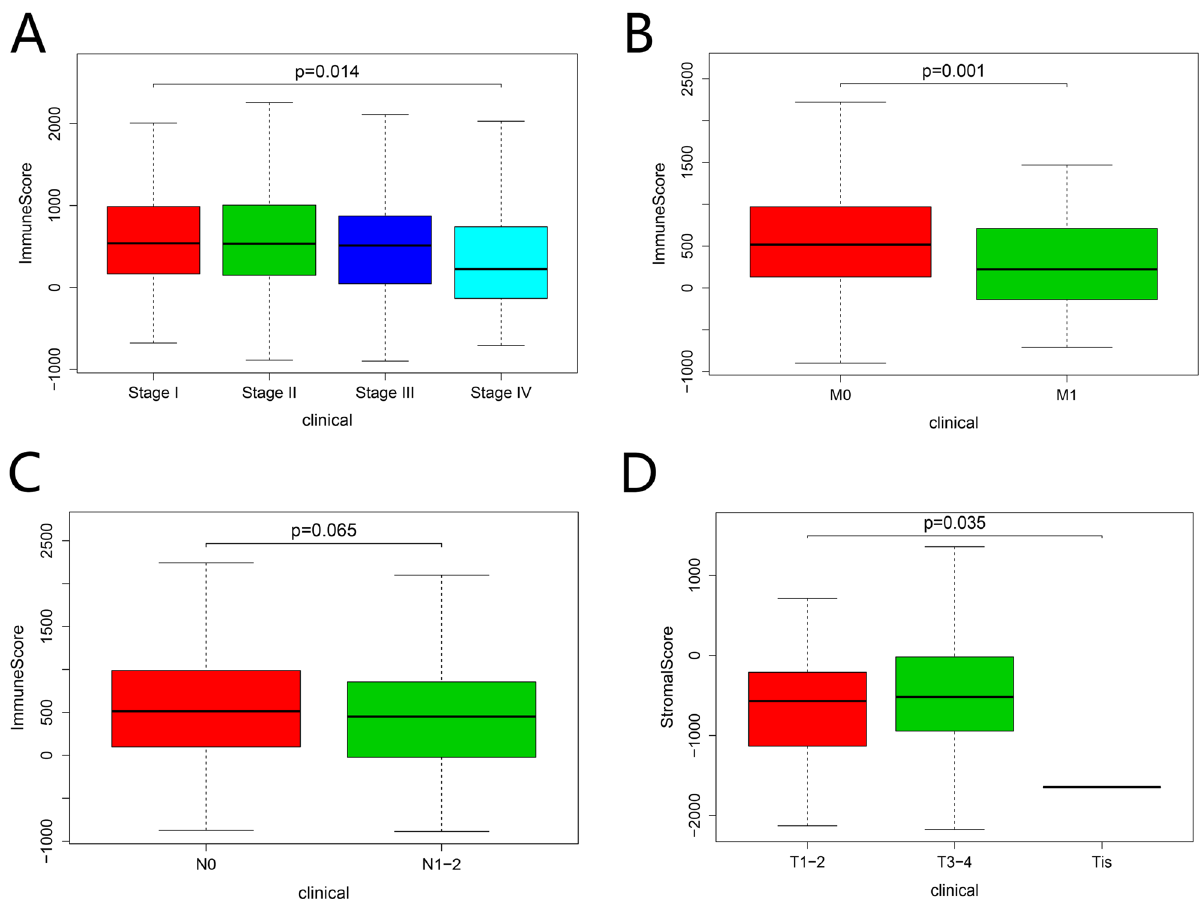
Figure 1. Lower immune scores are significantly related to malignant progression of CRC. The histogram revealed the distribution of immune scores in CRC-stage (p = 0.014) ( A ), CRC-M (p = 0.001) ( B ), CRC-N (p = 0.065) ( C ). Lower immune scores were associated with stage and tumor metastasis cases. The distribution of stromal scores in CRC-T (p = 0.035) ( D ). High-stromal score was associated with tumor